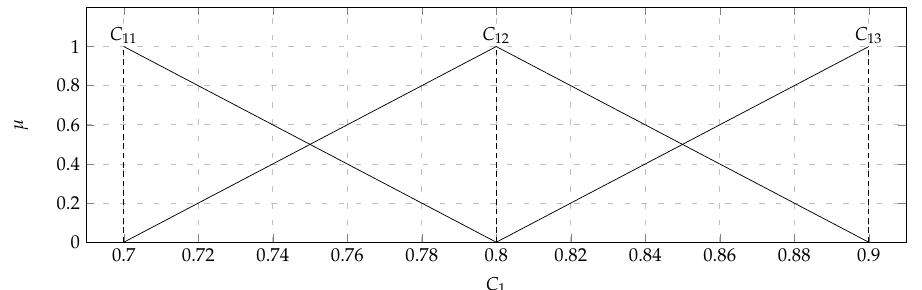
Figure 4. Visualization of Average kills per round ( C 1 ) and triangular fuzzy numbers 0.70 ( C 11 ), 0.80 ( C 12 ), and 0.90 ( C 13 ).